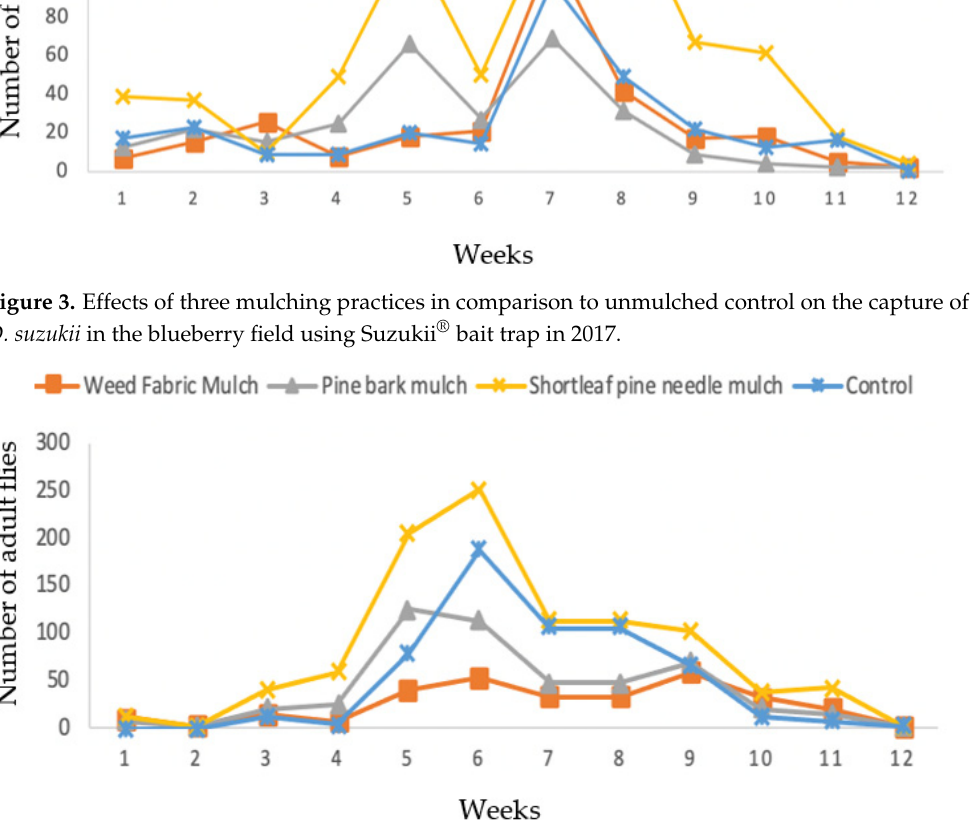
Figure 4. Effects of three mulching practices in comparison to unmulched control on the capture of D. suzukii in the blueberry field using Suzukii ® bait trap in 2018. Table 3. Average numbers of adult D. suzukii collected on blueberries using Suzukii ® bait trap during the sampling periods in 2017 and